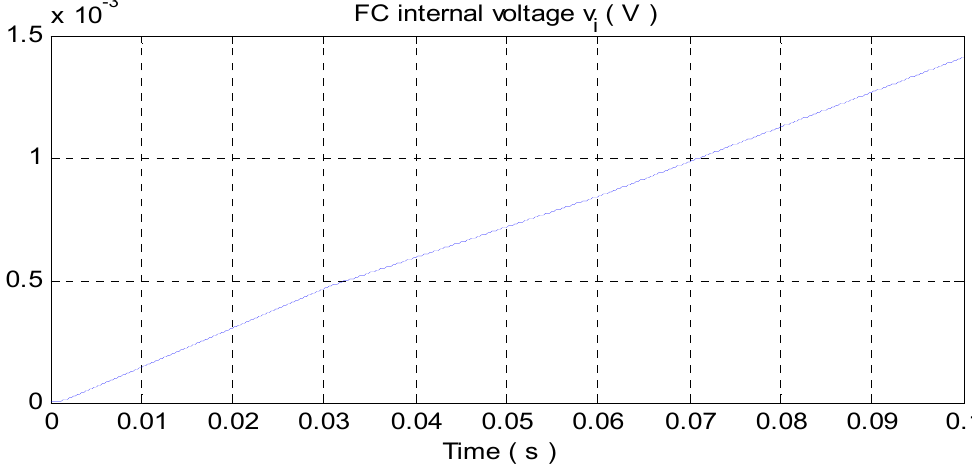
Figure 15. Control signals μ 1 k with zoom. Figure 16. Pulse width modulation of IBBC with zoom.